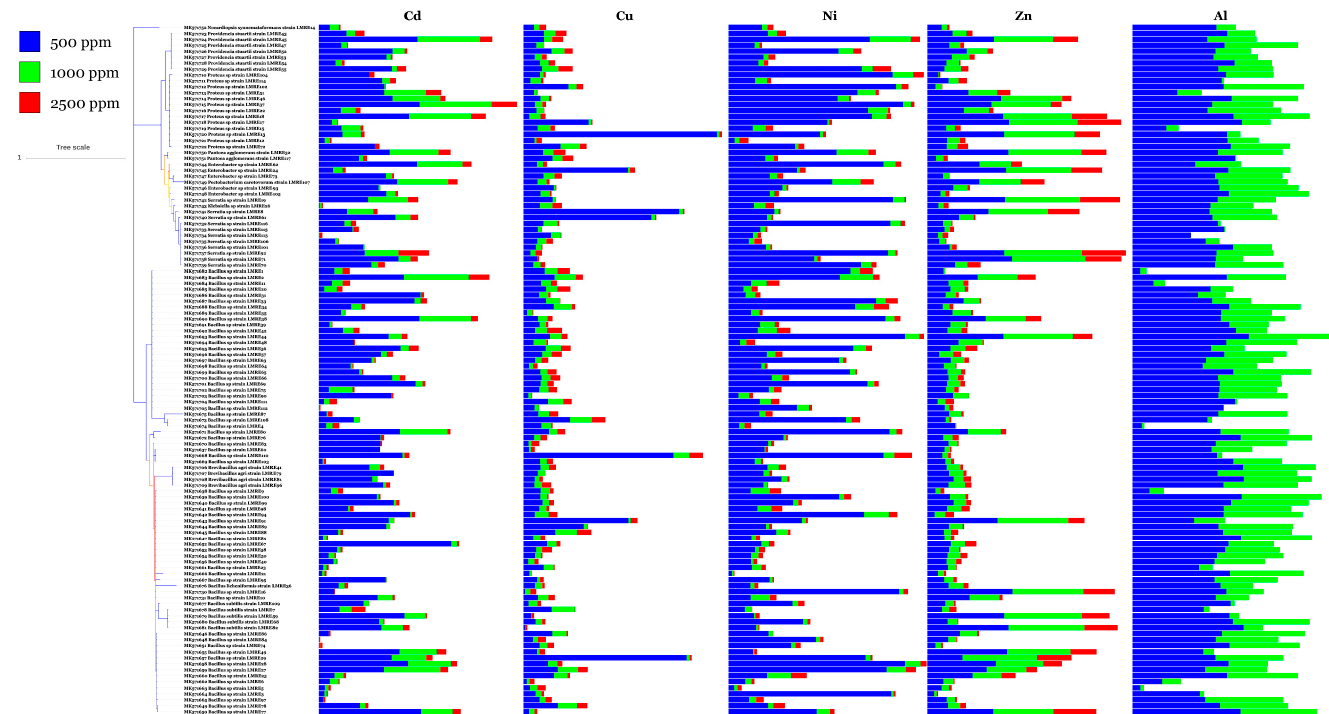
Figure 9. Multi-value bar-charts of heavy metal (Cd, Cu, Ni, Zn and Al) resistance of Gram-positive and Gram-negative bacterial isolates. (Dilutions of heavy metals: 500 ppm, 1000 ppm and 2500